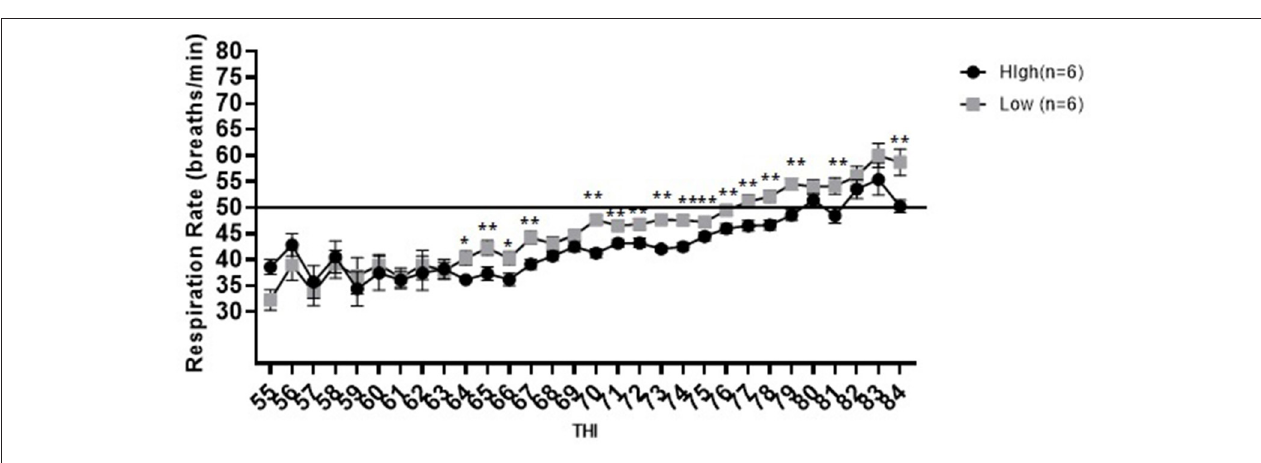
FIGURE 3 | Respiration rate in breaths per minute vs. temperature humidity index for high and low immune responding cattle housed in the tie-stall. Data are presented as least squared means of untransformed data, with error bars representing standard error for each mean. Double stars above the error bars indicate that a significant difference [65 ( p = 0.036), 67 ( p = 0.006), 70 ( p < 0.001), 71 ( p = 0.016), 72 ( p = 0.006), 73 ( p < 0.001), 74 ( p < 0.001), 75 ( p = 0.019), 76 ( p = 0.007), 77 ( p = 0.001), 78 ( p < 0.001), 79 ( p < 0.001), 81 ( p < 0.001)] was observed and a single star above the error bar represents a trend [64 ( p = 0.06), 66 ( p = 0.056)] was observed. The line at 50 breaths per minute represents the maximum normal respiration rate for dairy